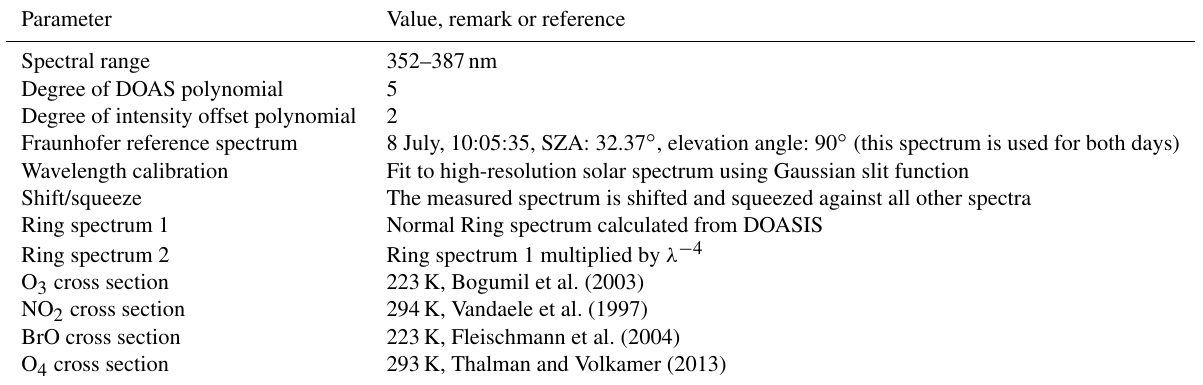
Table 7. Standard settings for the DOAS analysis of O 4 .